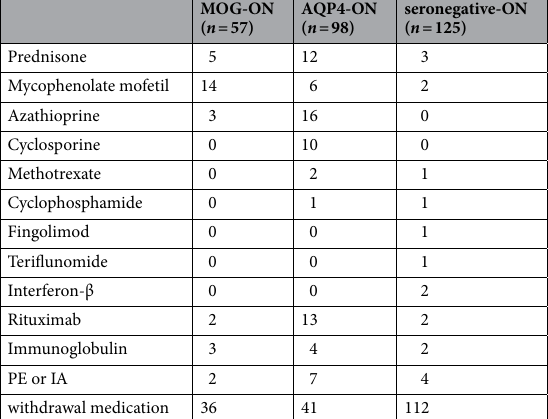
Table 3. Treatment agents used in each of the three phenotypes of optic neuritis. MOG, myelin oligodendrocyte glycoprotein; AQP4, aquaporin-4; ON, optic neuritis; PE, plasma exchange; IA,